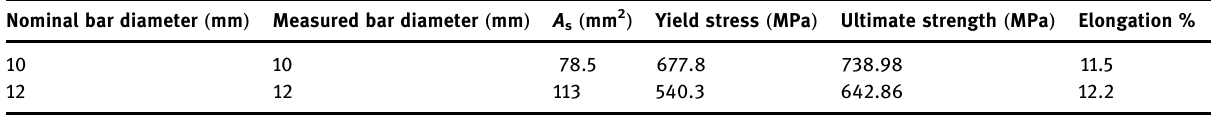
Table 13: Properties of steel reinforcement